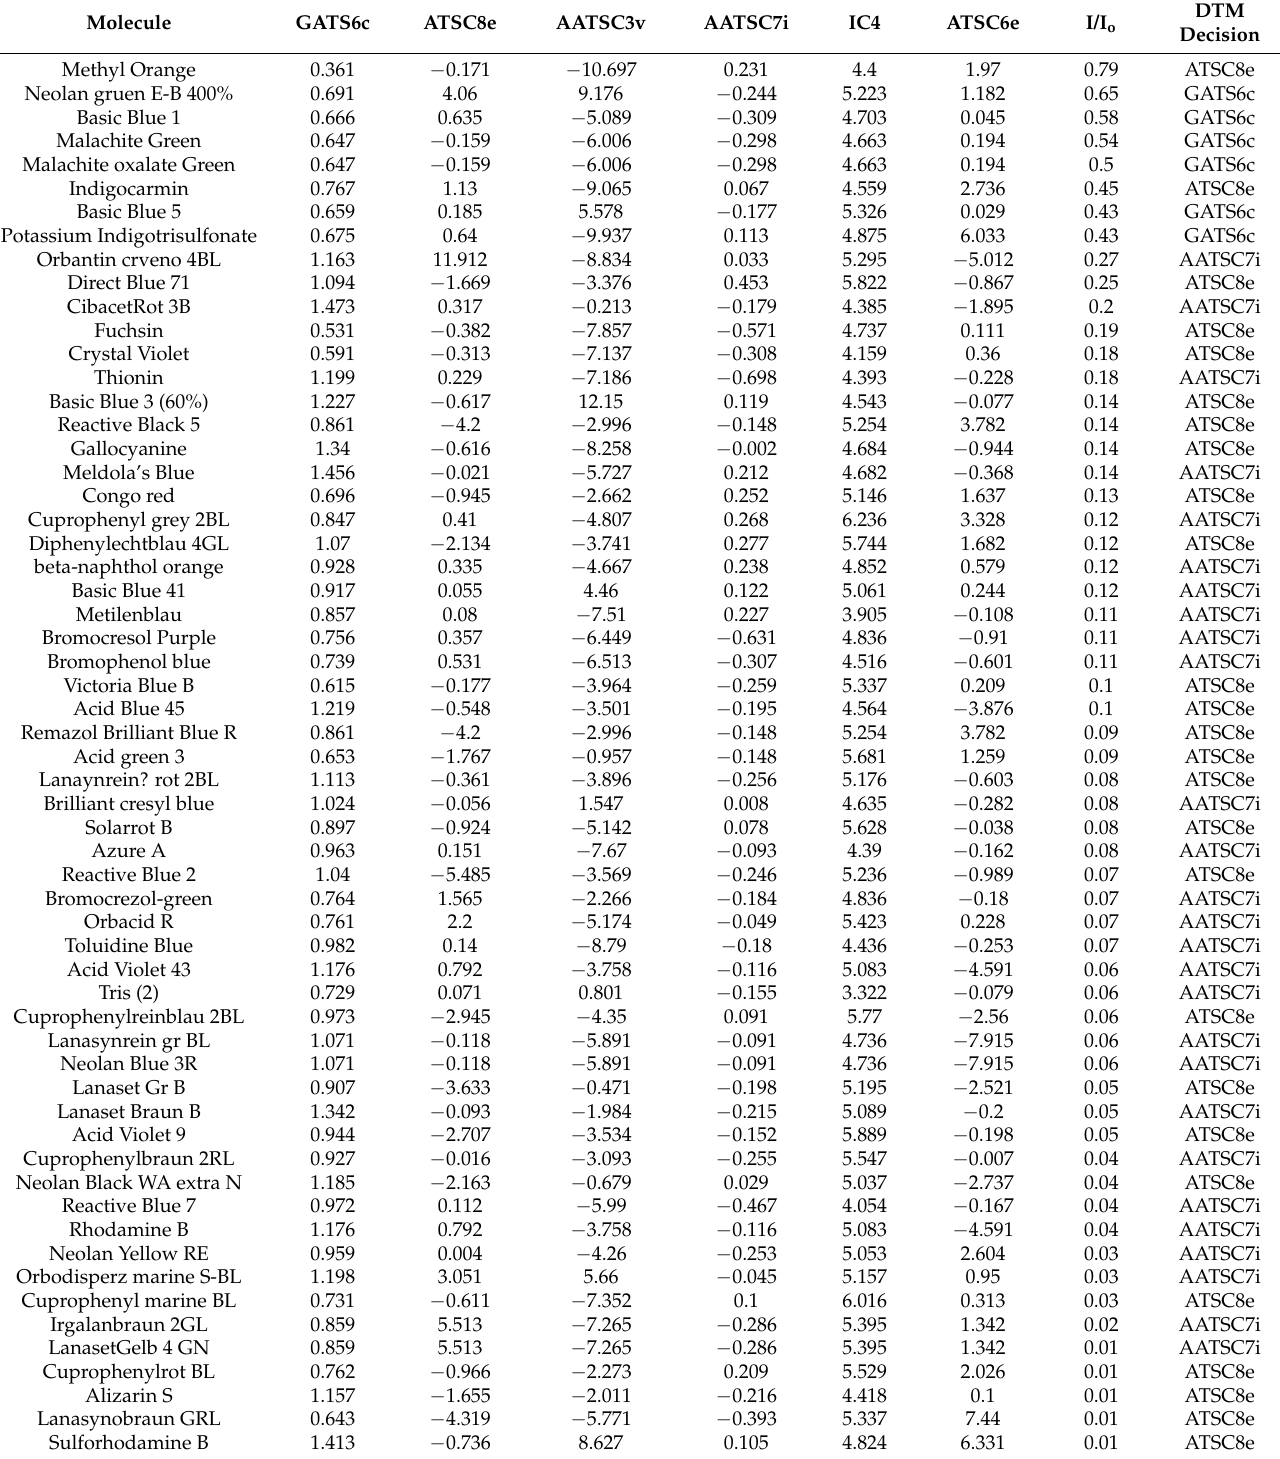
Table 1. Molecular descriptor values and corresponding DTM critical